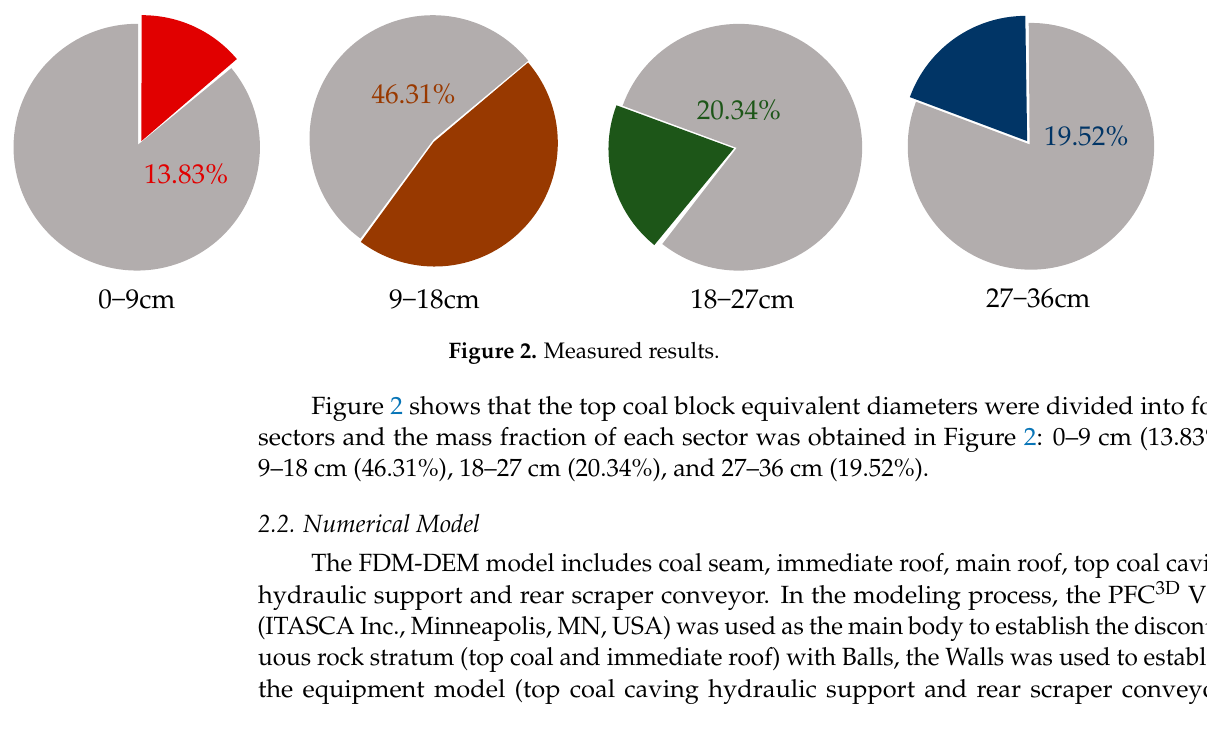
Figure 2. Measured results.